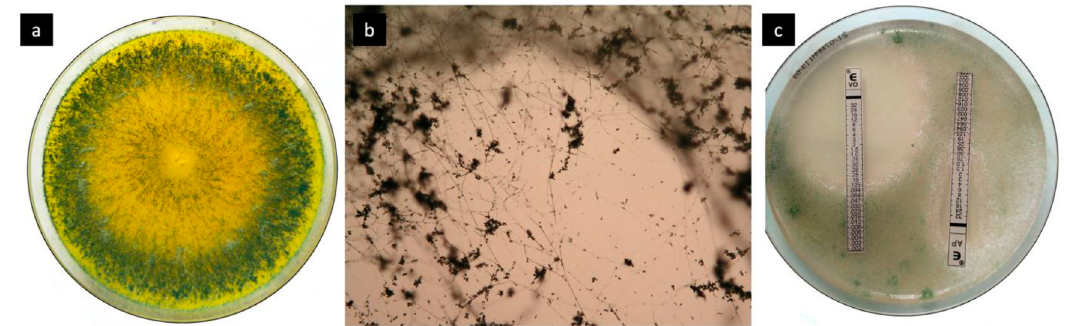
Figure 3. ( a ) Petri dish colonized by T. longibrachiatum , ( b ) microscopical view of T. longibrachiatum , ( c ) Etest of sensitivity to voriconazole (VO) and amphotericin (AP).